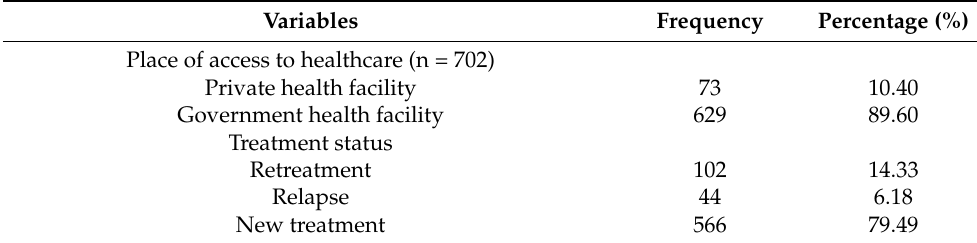
Table 3. Clinical characteristics of the study participants (n =